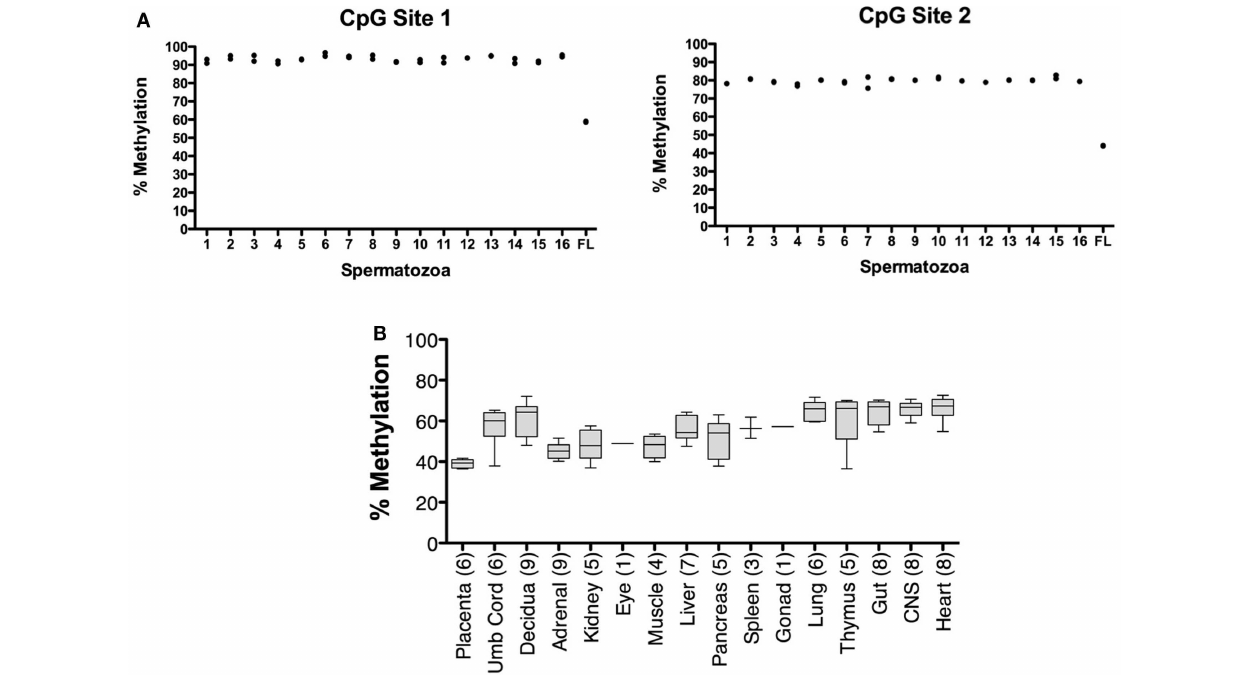
FIGURE 4 | Characterization of IGF2 intron 3 CTCF binding motif methylation in spermatozoa and human fetal tissues . (A) Measurement of % methylation ( y axis) for both CpG dinucleotides (CpG Site 1, CpG within the CTCF binding motif; CpG Site 2, CpG adjacent to the CTCF binding motif) in 16 individual human spermatozoa specimens (1–16 on x axis) and in human